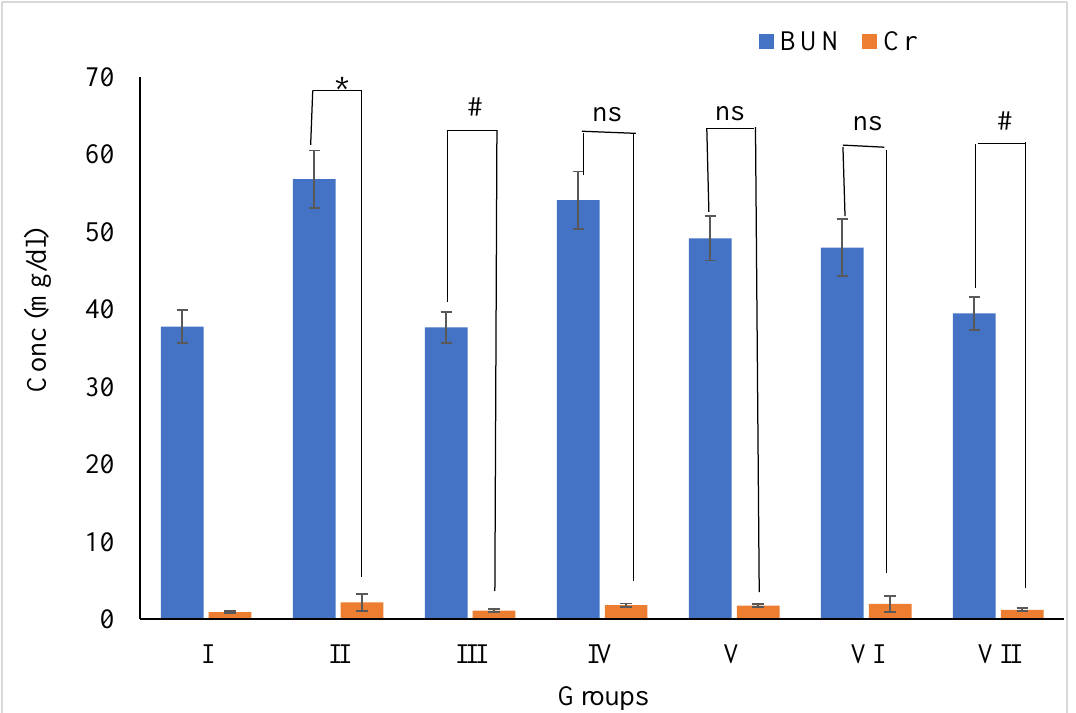
Figure 11. Effects of Wt-F of B. diffusa extract on BUN and creatinine in SD rats after 60 days of treatment. Where BUN = Blood Urea Nitrogen. Data are expressed as Mean ± SEM of 6 rats in each group. p -value = * < 0.01 showed significance compared with respective group I, p -value = # < 0.01 showed significance compared with respective group II and ns = non-significant compared with respective group II.